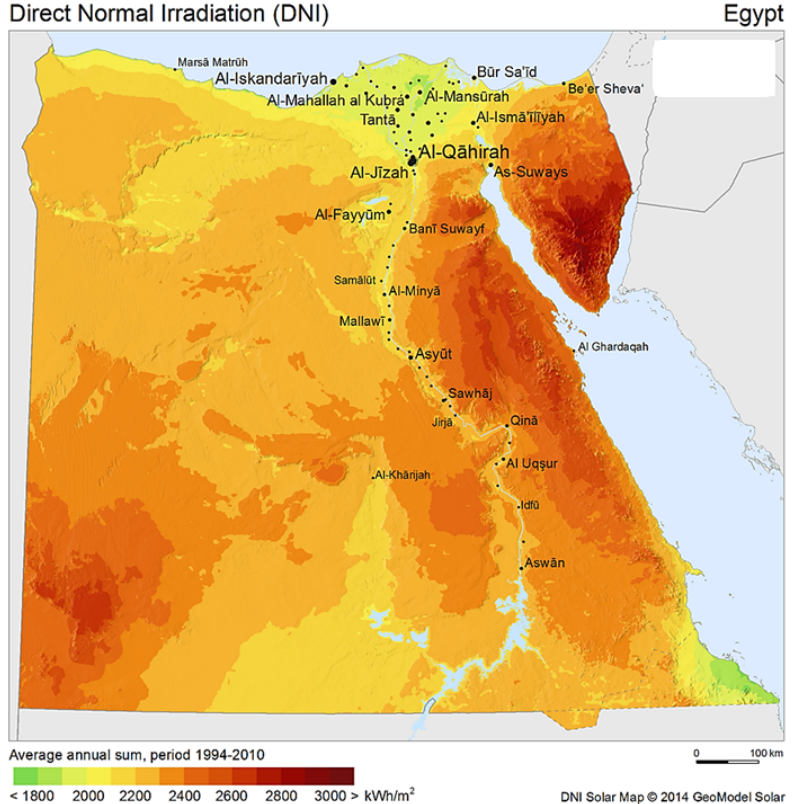
Figure 4. Potential of solar and wind energy in Egypt (source: Solar GIS http://solargis.info). Fossil fuels have shared 91% of the electricity generation, in addition to 9% from RES. Of the 9% RE generation, there is 7.7% hydro-power, 1.2% wind and 0.1% solar [41]. In recent years, the Egyptian Electricity Holding Company (EEHC) has faced a gap on the power supply side, which caused recurring power cuts from 2012 to 2015. This gap will increase if the lack of investment in energy generation, both conventional and renewable,